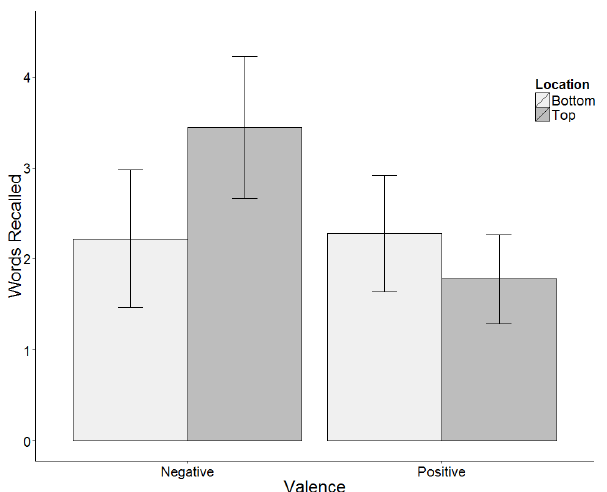
Figure 1. Mean number of words recalled by valence and location. Experiment 1.